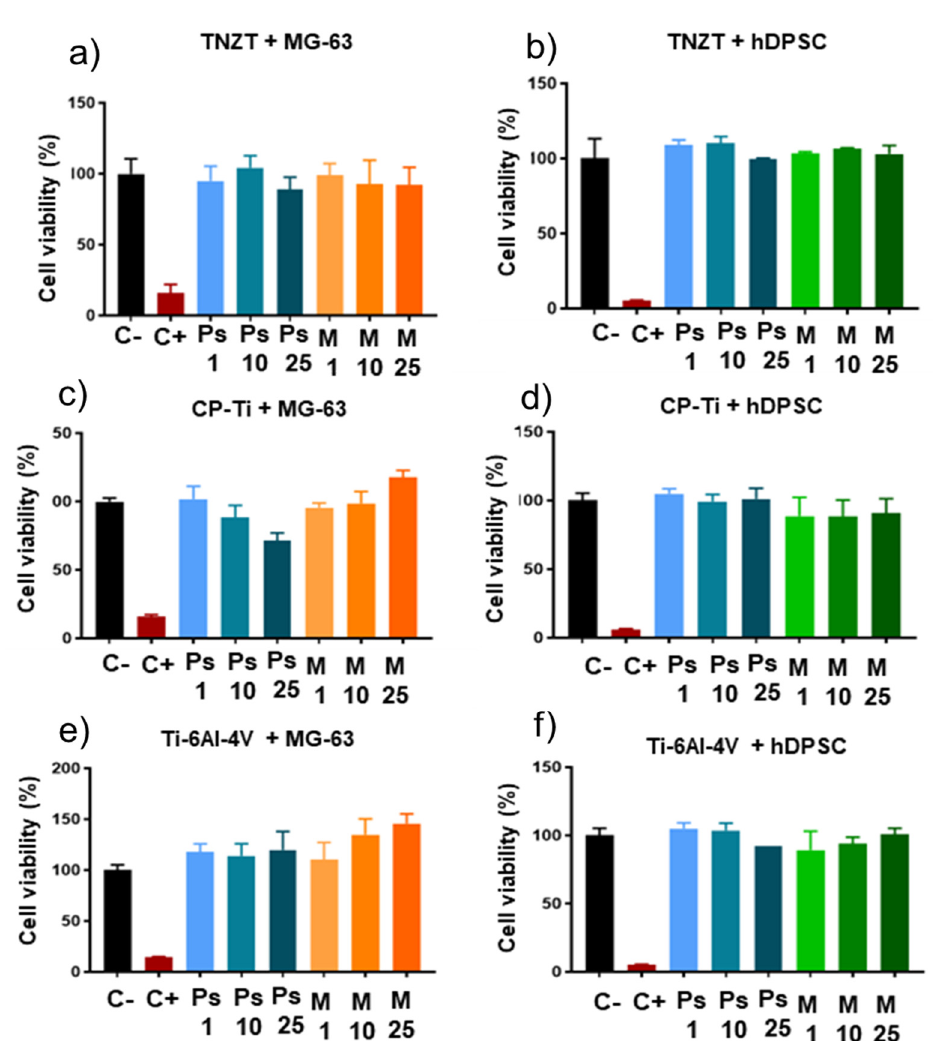
Figure 10. Cell viability of cells hDPSCs and MG-63 cells when they came into contact with different pure saliva (PS) concentrations, and also with the different concentrations of the ion released solutions containing possible ions related to as-cast TNZT, CP-Ti and Ti-6Al-4V. ( a ) Cell viability of as-cast Ti-Nb-Zr-Ta in contact with MG-63. ( b ) Cell viability of as-cast Ti-Nb-Zr-Ta in contact with hDPSCs. ( c ) Cell viability of CP-Ti in contact with MG-63. ( d ) Cell viability of CP-Ti in contact with hDPSCs ( e ) Cell viability of Ti-6Al-4V in contact with MG-63. ( f ) Cell viability of as-cast Ti-6Al-4V in contact with hDPSCs.